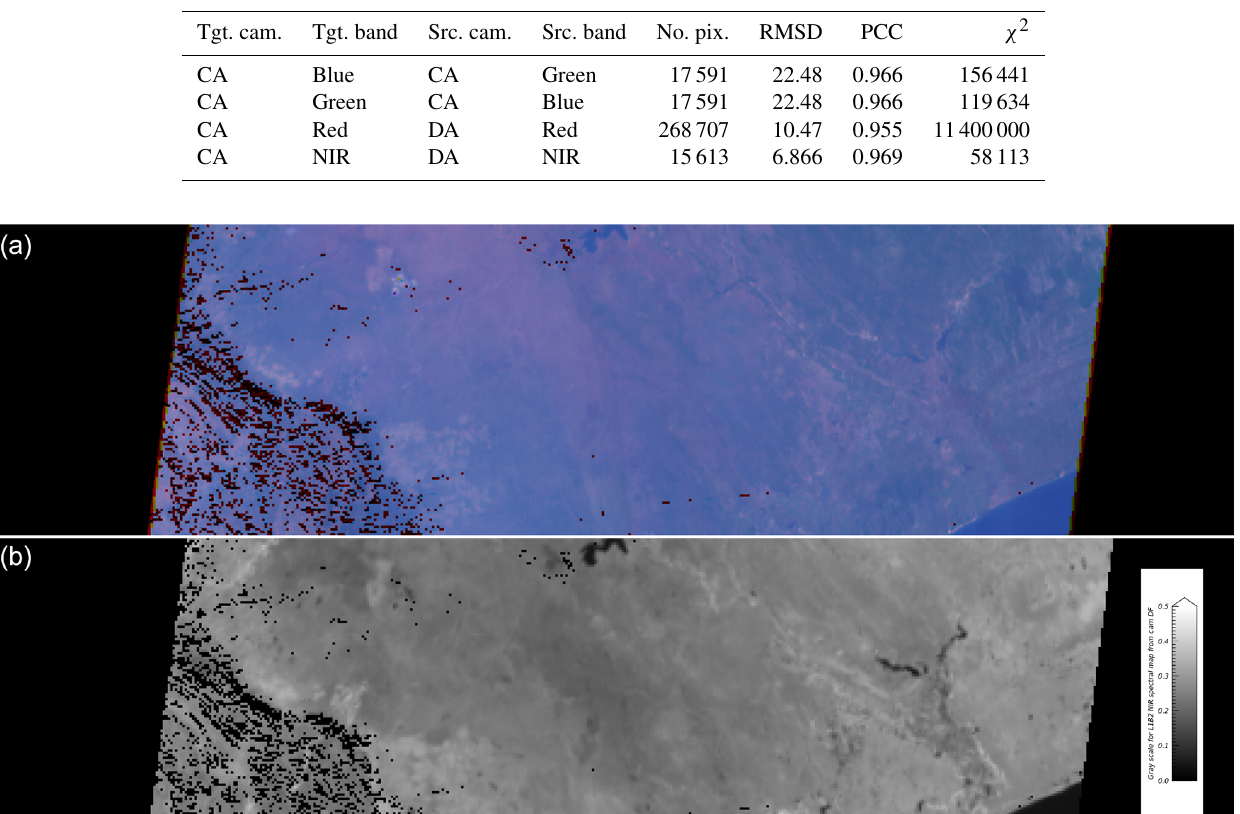
Table 4. Correlation statistics between the four spectral bands of the target camera CA and the best-correlated source data channels using only common and valid clear land values for the G LOBAL M ODE measurements acquired in P ATH 168, O RBIT 65487 and B LOCK 110. The column headers are identical to those in Table 2.